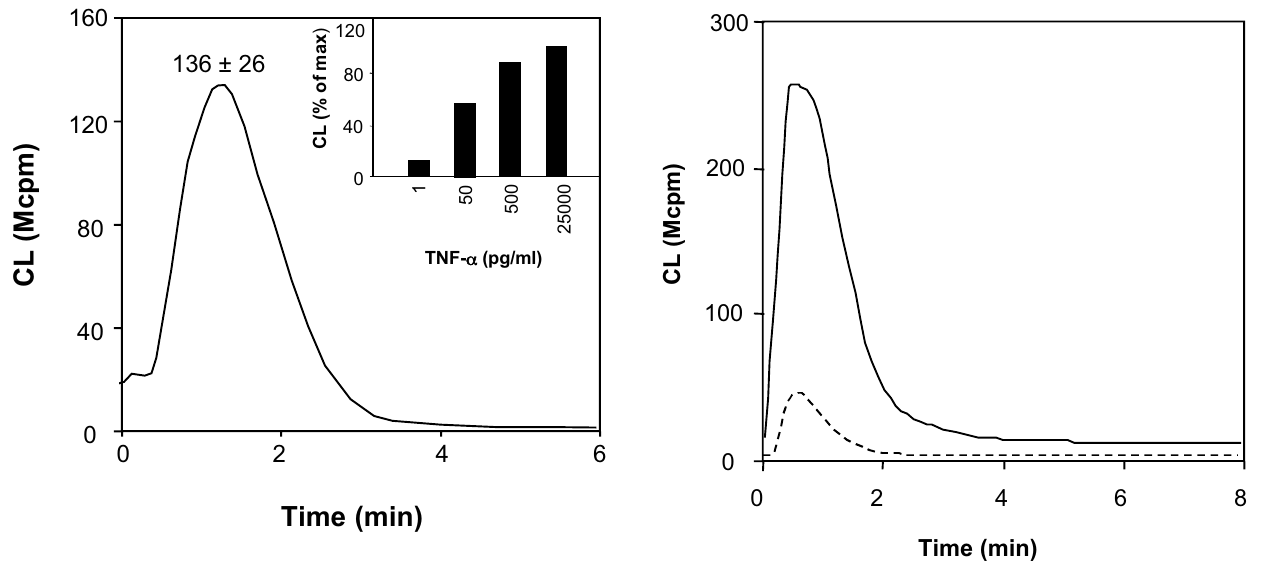
Figure 2 fMLF stimulation of TNF- α primed neutrophils. Neu- trophils were pre-incubated in the absence (dashed line) or presence (solid line) of TNF- α (25 ng/ml) for 20 min at